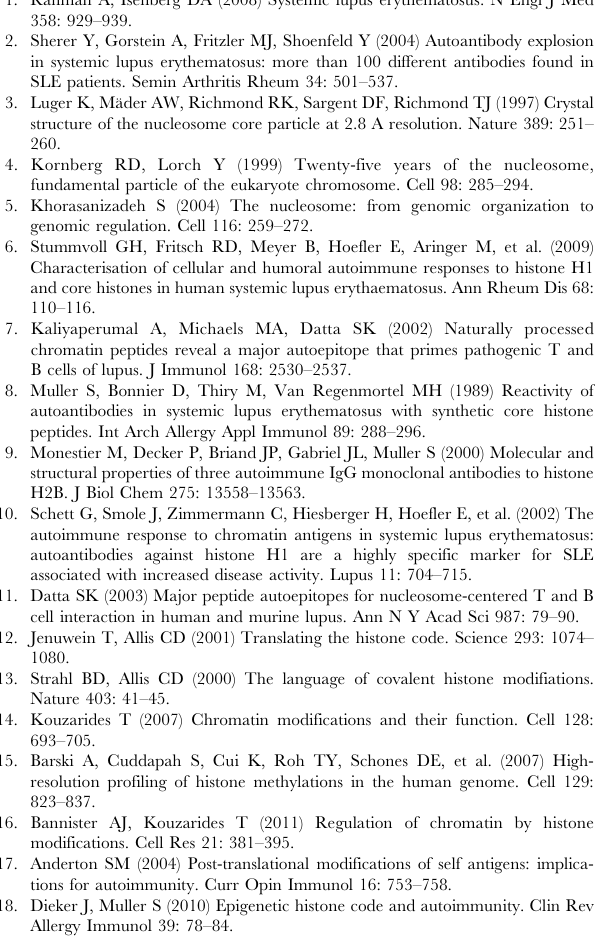
Table S2 Treatments received by SLE patients at blood collection. GC, Glucocorticoids; IS, Immunosuppressants; AM, Antimalarials; mAbs, monoclonal antibodies; IVIG, Intravenous immunoglobin. a, The number of patients treated with/without that medicine. Table S3 Peptides and their